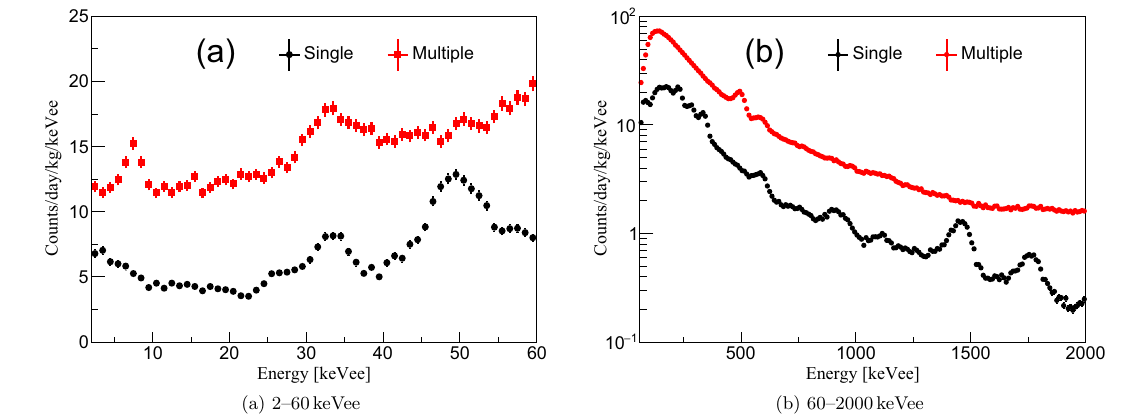
Fig. 15 Background spectra of the NEO-5 crystal, which are mea- sured using the full power of the reactor, are shown for the single- hit (black dots) and multiple-hit (red squares) events. An effective